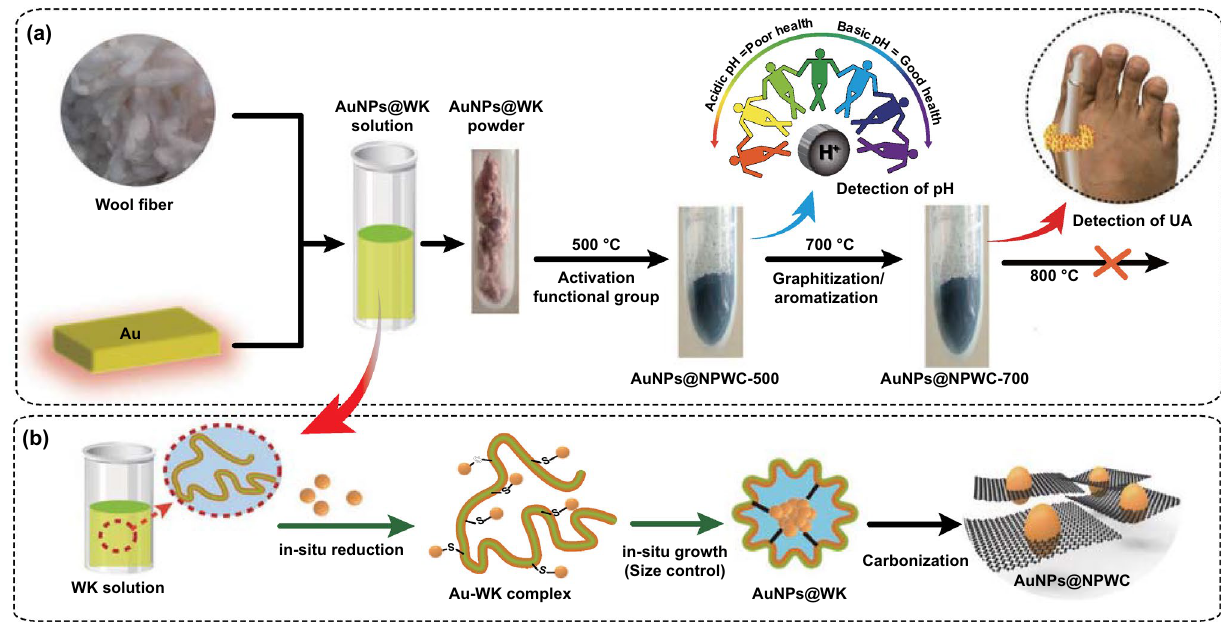
Fig. 2 Preparation of well-engineered AuNP-doped porous carbonaceous materials. a Controlled preparation process of AuNPs@NPWC with structure manipulation to achieve diverse performance to target different applications. At 500 °C carbonization temperature, composite mate- rial possessing high % of N in the form of graphitic, pyridinic, and pyrrolic with carboxylic groups showing high sensitivity toward pH sensing, whereas at carbonization temperature 700 °C, composite material owed more aromatization, high porosity, tightly anchored, and well-dispersed spherical AuNPs, which is more sensitive for UA sensing application. b Schematic illustration showing in situ reduction and synthesis of AuNPs with subsequent encapsulation to the final carbonized AuNPs@NPWC composite